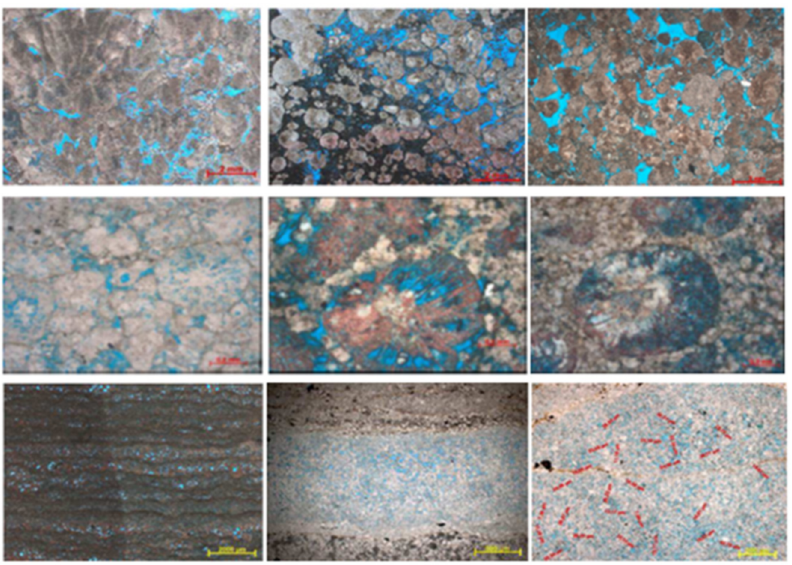
Figure 4. SEM results of the main reservoirs. The rows, from top to bottom, represent the G1 layer, G2 layer and G3 layer, respectively.